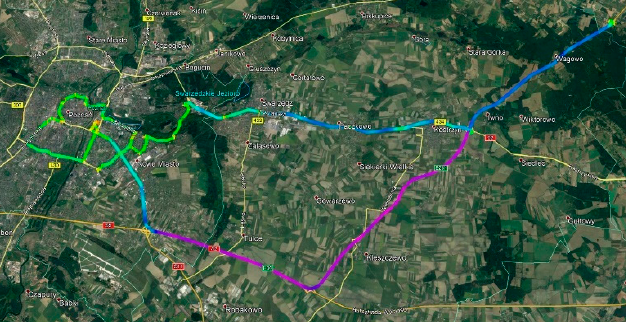
Figure 28. Test route to comply with the real driving emissions test requirements for both hybrid vehicles (legend: █ —0–50 km/h, █ —51–90 km/h, █ —91–130 km/h).